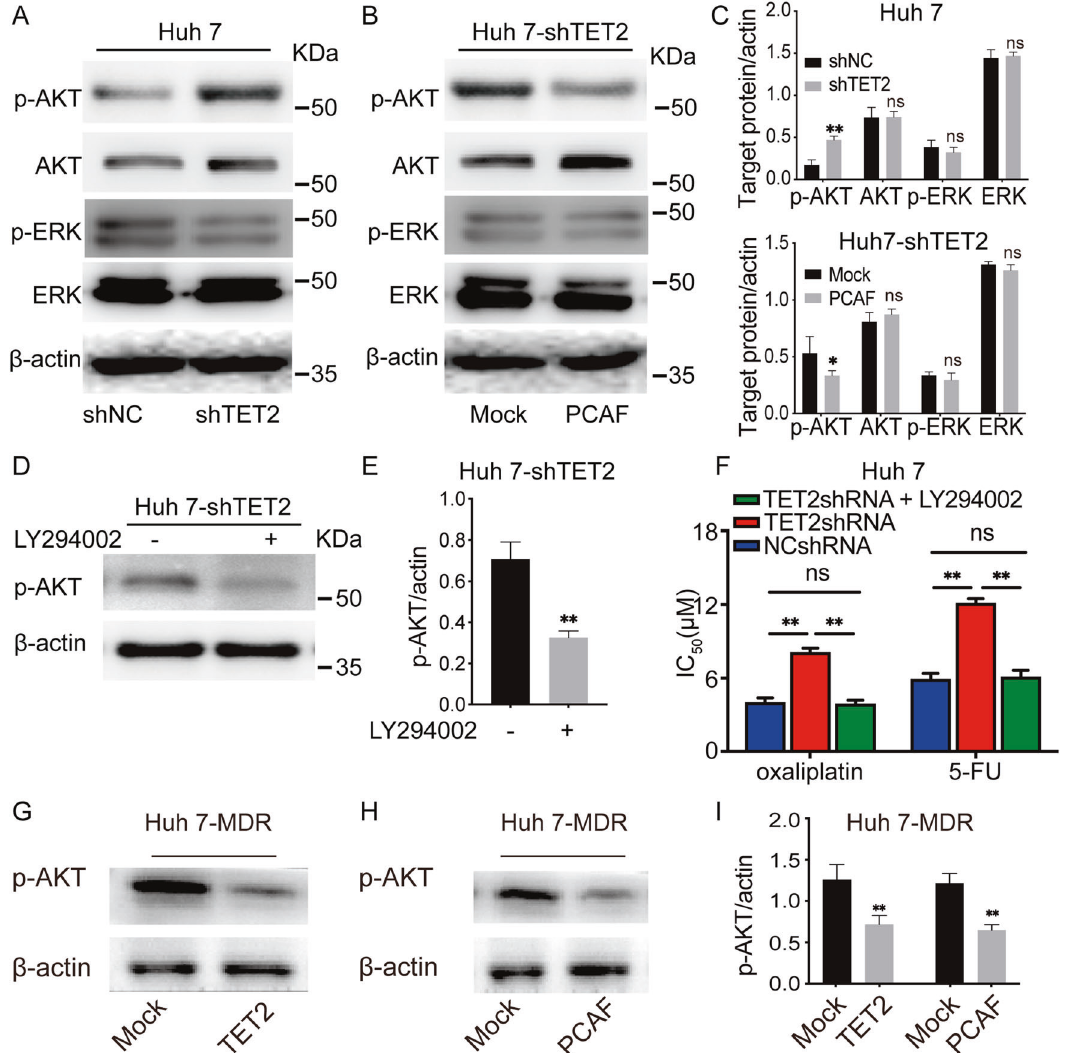
Fig. 5 TET2 regulates the PI3K/AKT pathway via PCAF regulation in HCC cells. A Western blot showing the expression of AKT, p-AKT, ERK, and p-ERK in HCC Huh 7-shNC and Huh 7-shTET2 cells. B Western blot showing the expression of AKT, and ERK in Huh 7-shTET2 cells with forced expression of PCAF. C Quanti fi cation of AKT, p-AKT, ERK, and p-ERK expression in Huh7, Huh7-shTET2, and PCAF forced Huh7-shTET2 cells; n = 3, t test, * P < 0.05; ** P < 0.01. D , E Western blot showing the expression of p-AKT in HCC Huh 7-shTET2 cells treated with LY294002; n = 3, t test, ** P < 0.01. F CCK-8 assay showing Huh 7-shTET2 sensitivity to oxaliplatin and 5-FU treated with LY294002; n = 3, One-way ANOVA, ** P < 0. 01. G – I Western blot showing the expression of p-AKT in Huh 7-MDR cells with forced expression of TET2 or PCAF; n = 3, t test, ** P < 0.01. All data are presented as mean ± SD; n = 3, * P < 0.05; ** P <